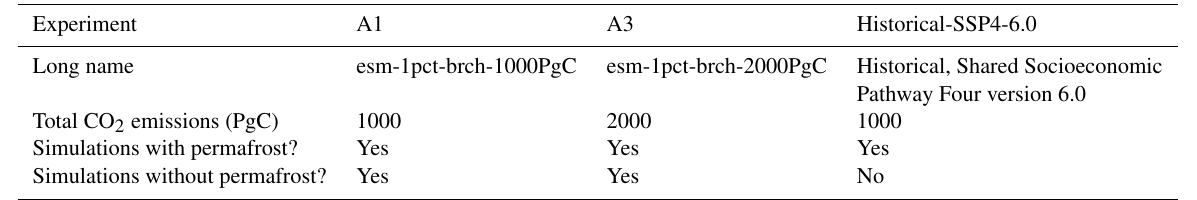
Table 1. Model experiments conducted in this study. Experiment A1 A3